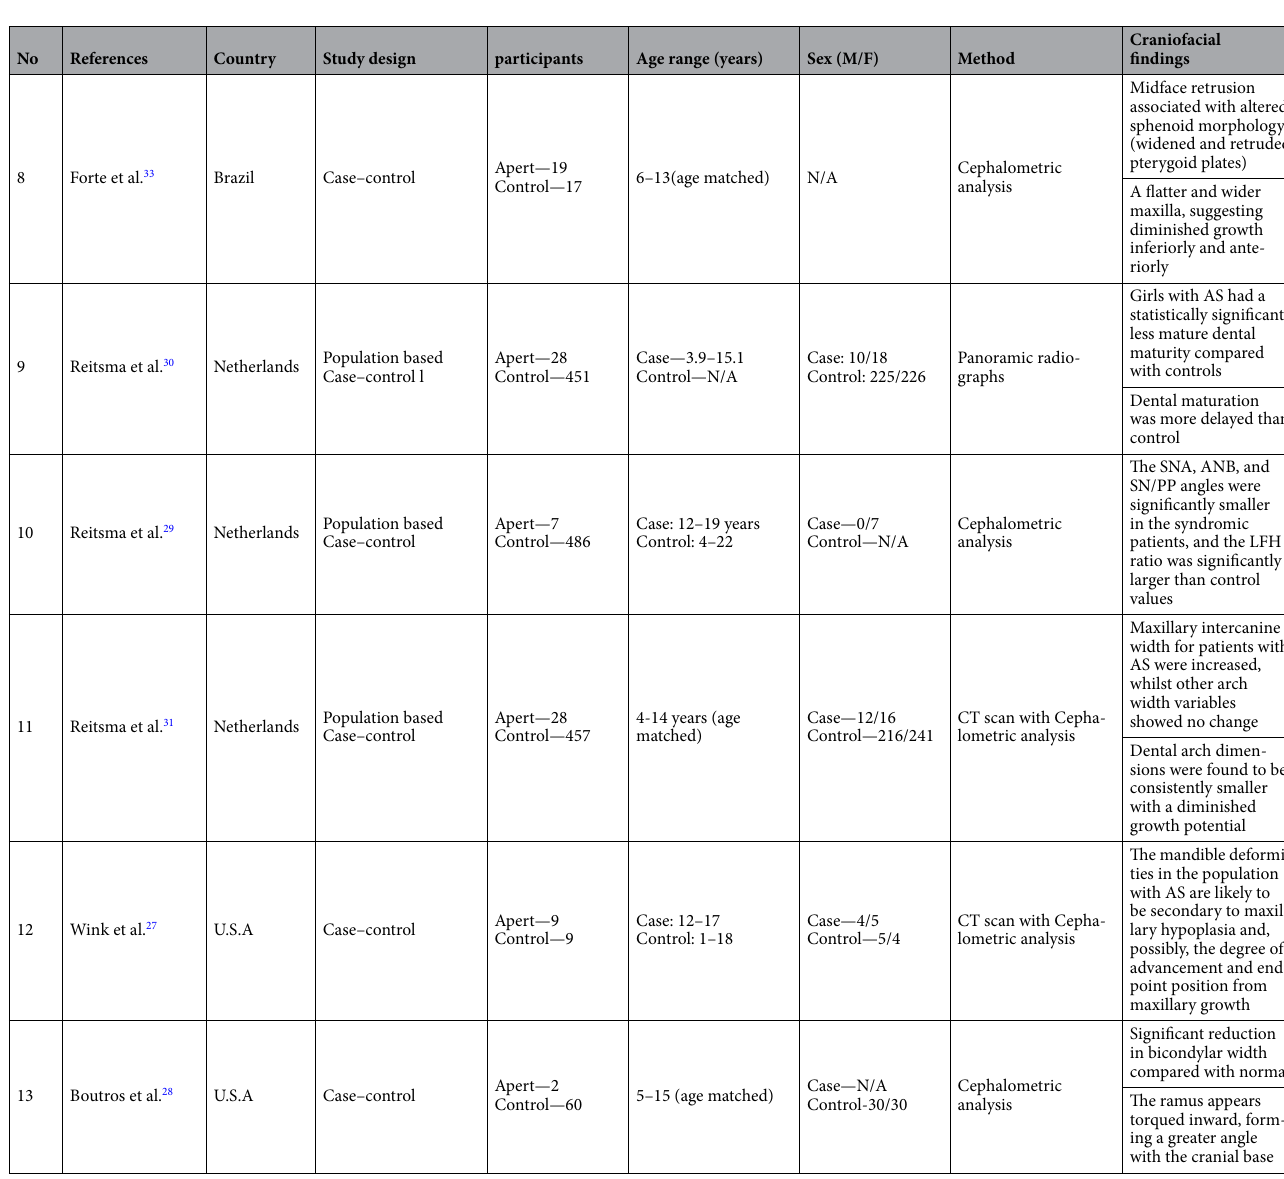
Table 2. Characteristics of the study included in the systematic review. N/A not available. *Mean